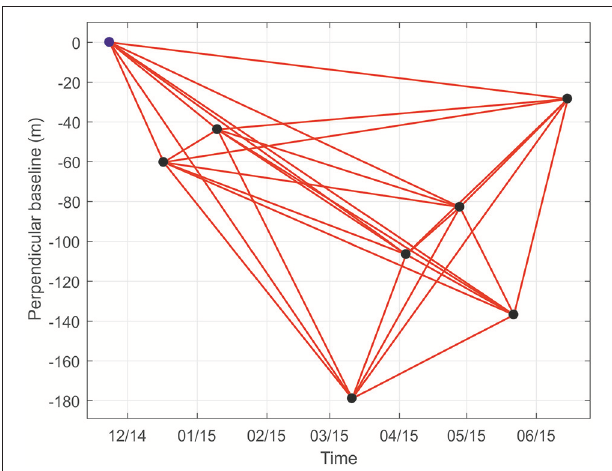
FIGURE 3 | Spatio-temporal distribution of Sentinel-1 data (descending track 12) used in this study. The effective spatial distance between orbits (perpendicular baseline) is represented as a function of the temporal distance (time gap) between the two satellite acquisitions. Red lines are for the interferograms computed and used for the time series inversion. Images were acquired on 23 November 2014, 17 December 2014, 10 January 2015, 11 March 2015, 4 April 2015, 28 April 2015, 22 May 2015, and 15 June 2015 at 12H50